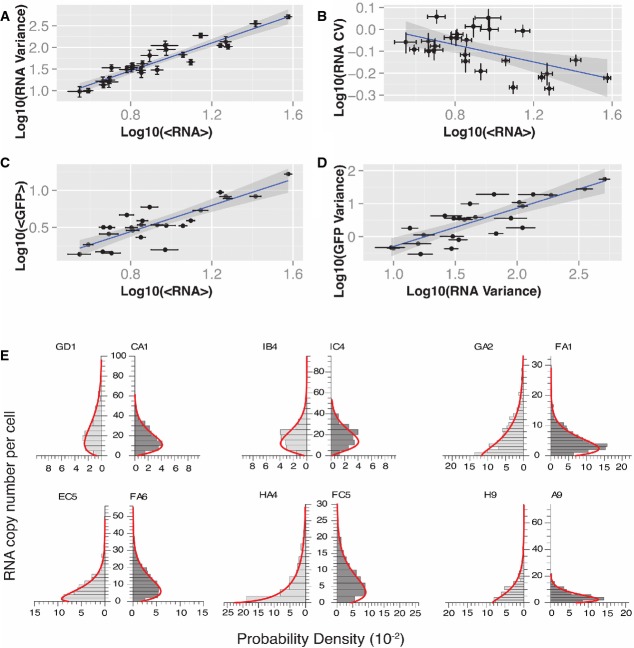
RNA distribution scaling and systematic fitting of RNA distributions reveal that LTR expression output is primarily controlled by intrinsic fluctuations in promoter activity

A RNA variance correlated with mean RNA copy number. Log-log linear regression of RNA variance as a function of RNA mean finds a high-confidence scaling with a slope of 1.68 ± 0.25 (R2 = 0.89, rs = 0.92, P < 0.001), which is intermediate to Poisson and ‘input-controlled’ scaling.

B RNA mean and noise primarily independent. Log-log linear regression of RNA CV (noise) as a function of mean finds an approximately uncorrelated of noise on mean expression (slope = −0.2 ± 0.13, R2 = 0.31, rs = −0.38, P = 0.03). This suggests that RNA mean and expression noise are controlled by primarily independent mechanisms.

C, D RNA distribution shape predominantly explains GFP distribution shape. RNA and GFP means are highly correlated (C) (R2 = 0.79, rs = 0.86, P < 0.001). Similarly, RNA and GFP variances are strongly correlated (D) (R2 = 0.73, rs = 0.84, P < 0.001), with RNA variance explaining the majority of variation observed in GFP variance. Together, these suggest that contributions to the mean and width of the protein distributions from processes downstream of transcription are minimal. Furthermore, this strongly implies that intrinsic transcriptional dynamics are the primary determinant of protein distribution shape.

E Maximum-likelihood fitting of a two-state model to RNA distributions. Copy number distributions were determined by smFISH and automated analysis of the set of 25 selected LGM2 clones. Resulting distributions were fit to the analytical probability density function (pdf) of a stochastic two-state transcriptional model through maximum-likelihood parameter estimation. mRNA copy number distributions are depicted as paired density histograms for six representative pairs of high noise (pair left, light gray) and low noise (pair right, dark gray). Each pair represents clones with similar mean expression but different CV. Experimentally determined histograms are shown overlaid with the probability density functions (red curve) evaluated using best-fit model parameters for each clone.

Data information: In (A–D), error bars on RNA moments represent 95% confidence interval estimates derived from bootstrapped smFISH distributions for each clone. rs represents the Spearman correlation coefficient for the explanatory and response variables in each pairwise regression, and P-values represent support for correlation.